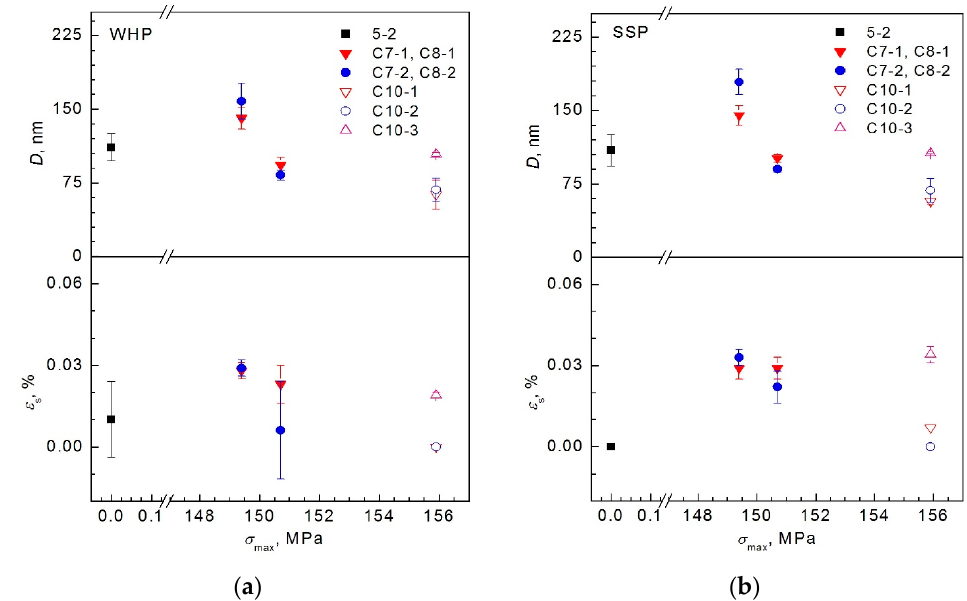
Figure 6. Microstructure parameters (average sizes D of crystallites of Al material of wires and absolute average values of microstrains ε s in them) for samples subjected to cyclic loading with different magnitudes of maximum load σ max , according to the results of calculations by methods of ( a ) WHP and ( b ) SSP.